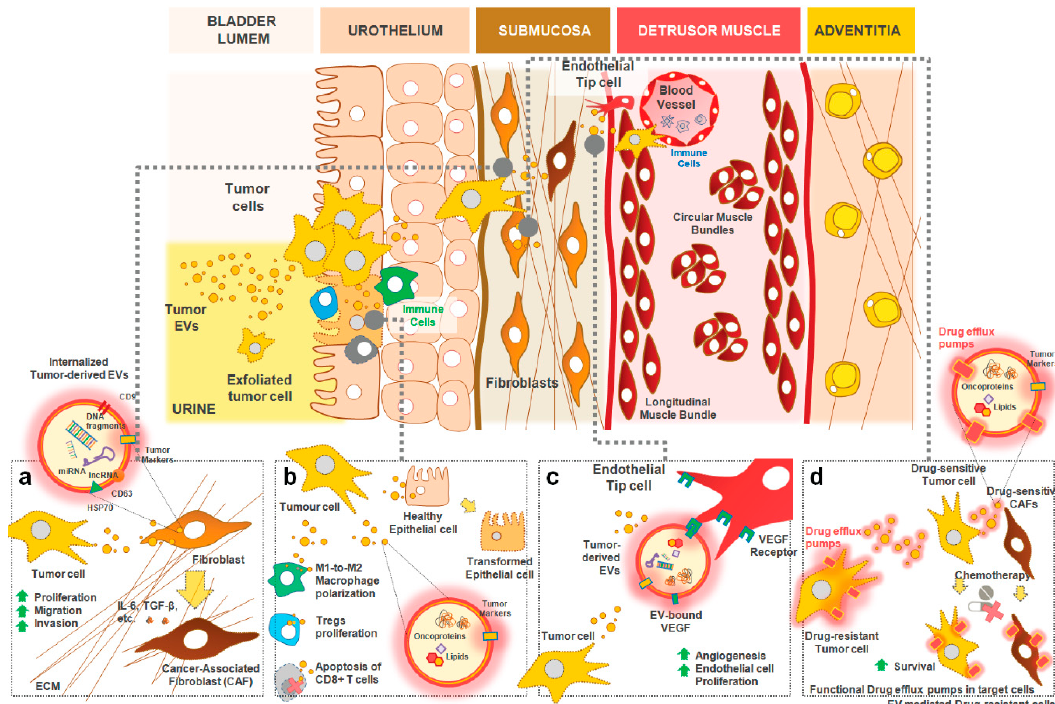
Figure 3. Routes of EV delivery to target cells and their potential role in bladder cancer progression. ( a ) Transfer of EV-enclosed nucleic acids derived urothelial carcinoma cells to nearby naïve fibroblasts can induce their transformation into Cancer-Associated Fibroblasts (CAFs) with altered pro-tumoral secretome. ( b ) Likewise, transfer of EV-associated lipids and/or oncoproteins to neighbor or distant cells modulate targeted immune cells into an immunosuppressive phenotype and/or facilitate the transformation of healthy epithelial cells. ( c ) Many of the signaling molecules that integrate the EVs membrane can act directly on the surface receptors of target cells and trigger their own cell signaling pathways without the need of EV internalization. ( d ) The uptake of EVs derived from drug resistant tumor cells by drug sensitive tumor cells (or even supporting stroma) can mediate the transfer of functional receptors/molecules to recipient cells, thus allowing a similar phenotypic behavior in cells that originally lacked those receptors/molecules (e.g., transfer of functional drug efflux pumps).